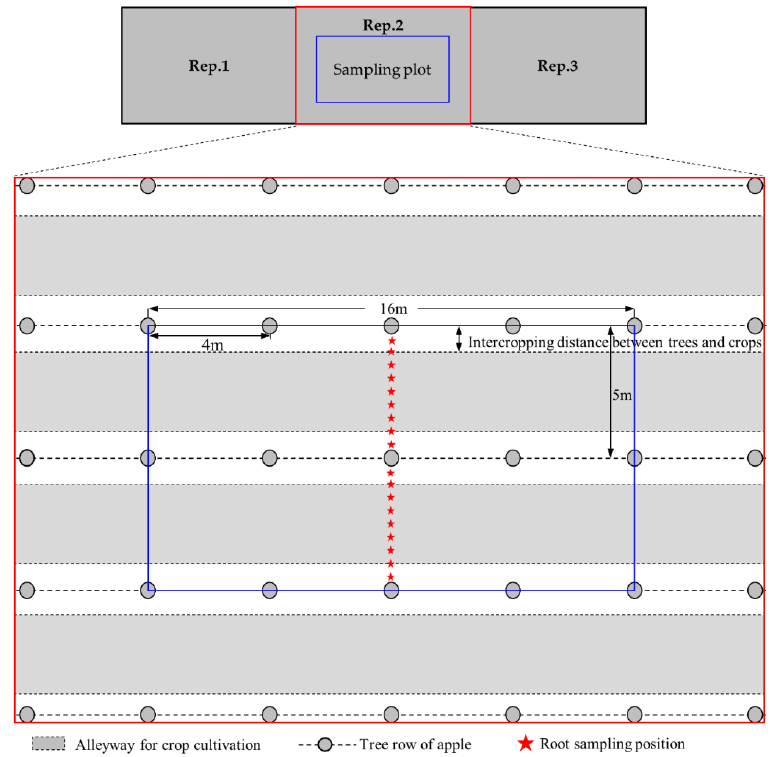
Figure 1. Sampling plot layout of the apple ( Malus pumila )/crop alley cropping system. Each plot included three tree rows and two alleyways. Rep. means the replication.